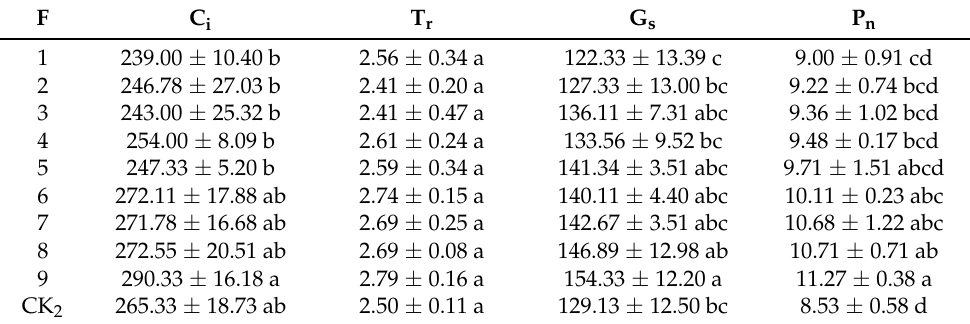
Table 5. Average effects of two years of N, P, and K fertilizer (F) in EXP.2 on the